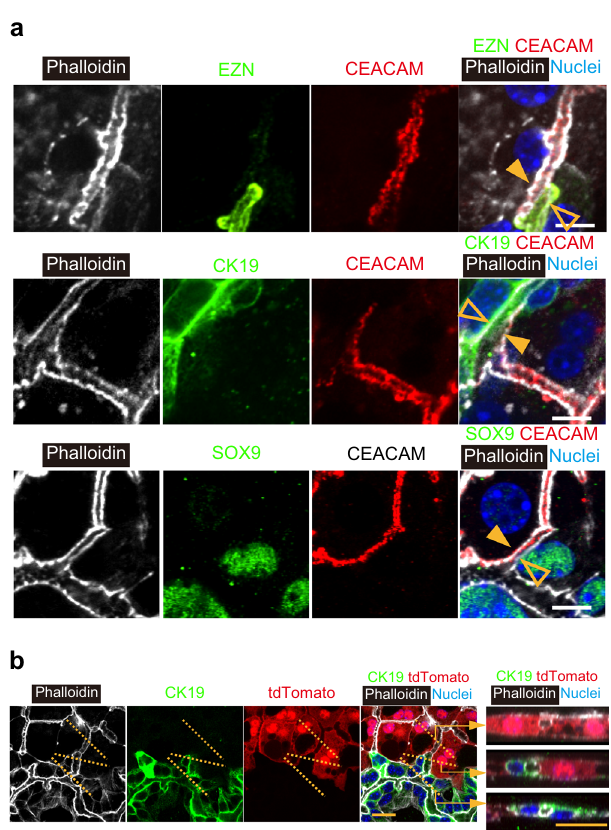
Fig. 2 Hepatocytes and cholangiocytes maintain their lineage to establish hepatobiliary junctions. a Immunological identi fi cation of the hepatobiliary junction. The hepatobiliary junction consists of hepatocytes (closed arrowheads) and cholangiocytes (open arrowheads). The continuous lumen stained with phalloidin (white) is surrounded by CEACAM + EZN − hepatocytes and CEACAM − EZN + cholangiocytes, CEACAM + CK19 − hepatocytes, and CEACAM − CK19 + cholangiocytes, or CEACAM + SOX9 − hepatocytes and CEACAM − SOX9 + cholangiocytes. The immunostaining using phalloidin, anti-CEACAM antibody (red), and Hoechst 33342 (blue) with anti-EZN (green), anti-CK19 (green), or anti-SOX9 (green) antibody was repeated three times independently. Three fi elds were examined in each sample and the representative images are shown in this fi gure. Bars represent 20 μ m. b tdTomato + hepatocytes maintain their lineage to form a continuous luminal network with cholangiocytes. Optical cross-sections along broken lines in the square four panels are shown in the far right panels. The luminal network among tdTomato + hepatocytes (upper right panel) is connected to that of the tdTomato − CK19 + biliary structure (lower right panel) at the boundary (middle right panel). The luminal network is recognized by F-actin bundles visualized using phalloidin. The immunostaining with phalloidin (white), anti-CK19 antibody (green), and Hoechst 33342 (blue) was repeated three times, independently. Two fi elds were examined in each sample. Two out of six areas were further used to collect serial optical sections for 3D reconstruction. The representative images are shown in this fi gure. Bars represent 40 μ